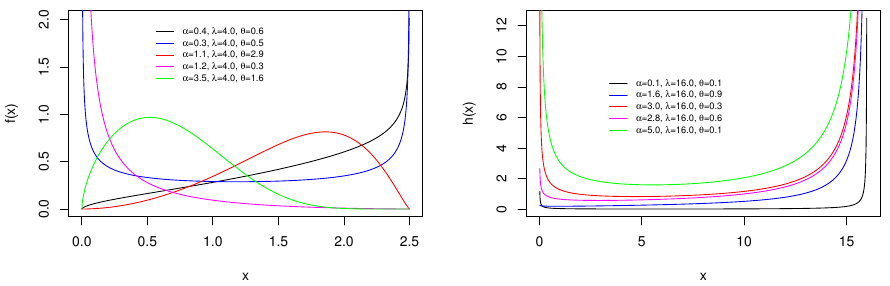
Figure 2. Plots of the pdf and hrf of the ECSP distribution for some parameter values.